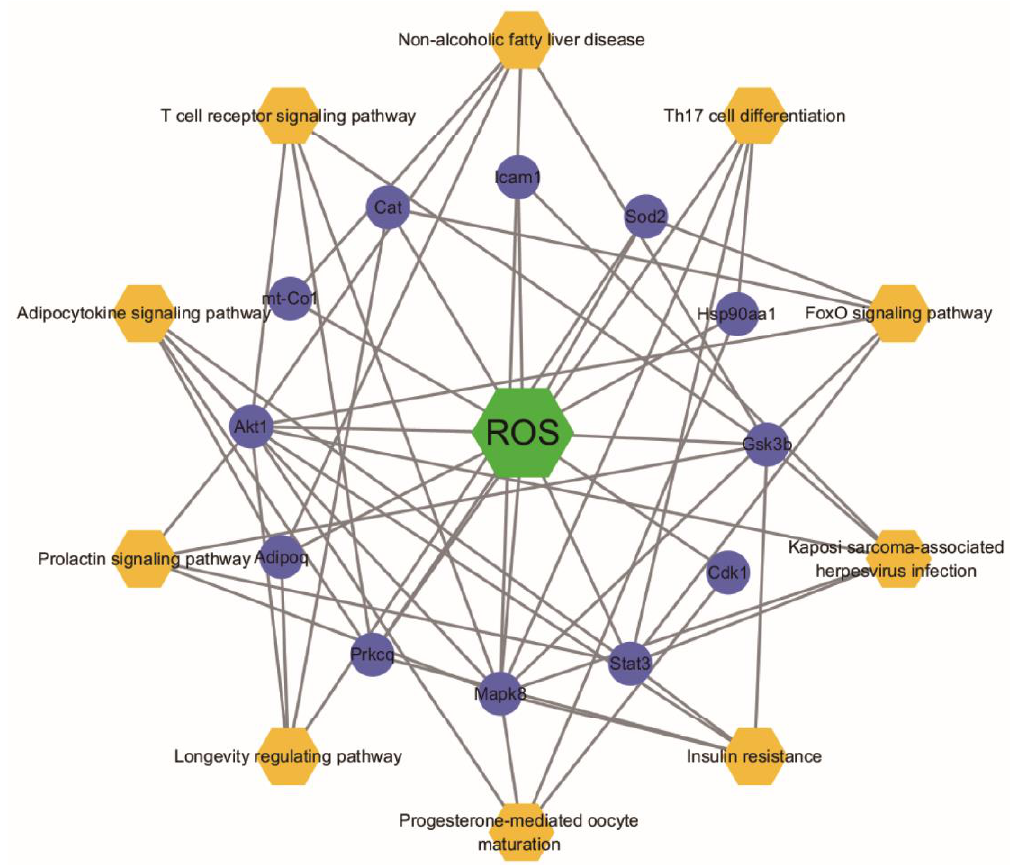
Figure 7. ROS-Target-Pathway network. Orange hexagons represent pathways, the green square represents ROS and purple rounds represent targets.